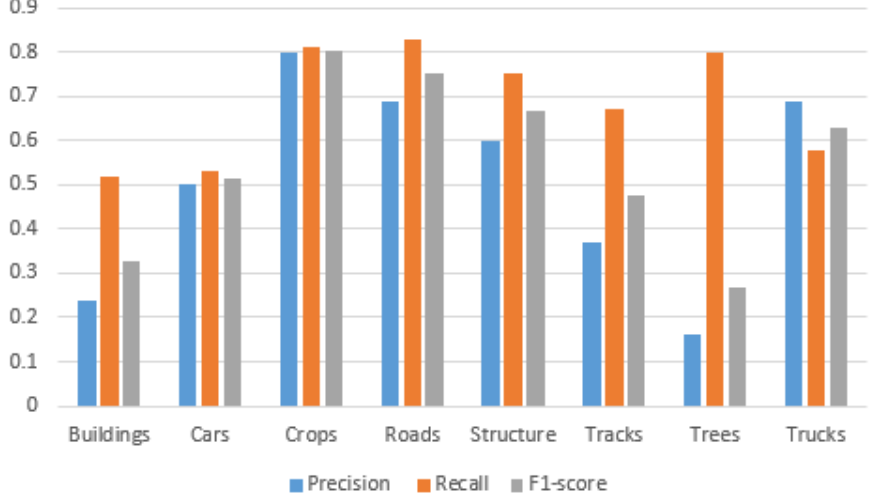
Figure 7. Results obtained with VGGNet for SIRI-WHU